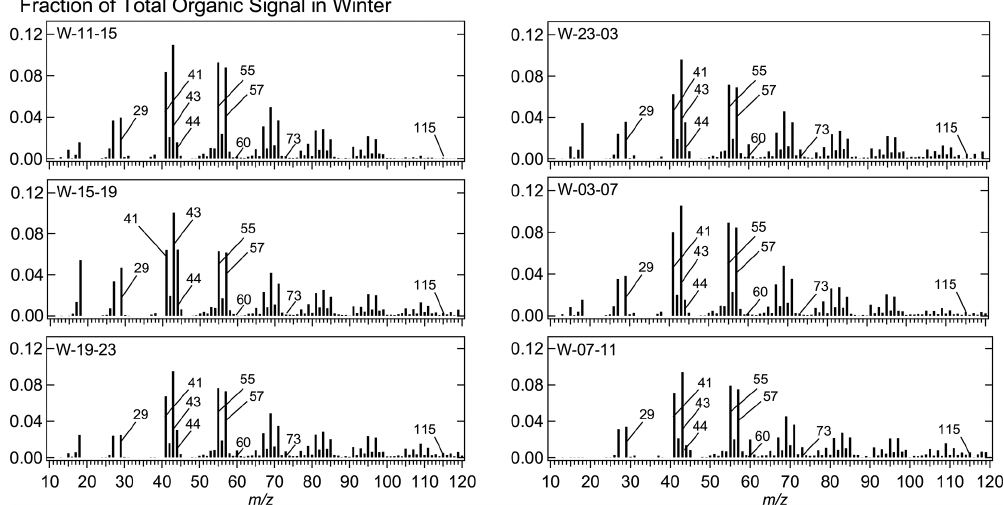
Figure 5. The mass spectrum of time-of-day PMF hydrocarbon-like organic aerosol (HOA) factor in winter 2017. The mass spectra remain fairly consistent across the time-of-day periods.